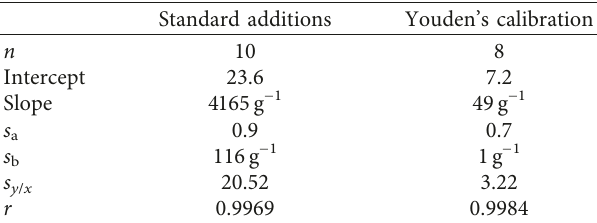
Table 3: Results of the least-squares regression analysis.